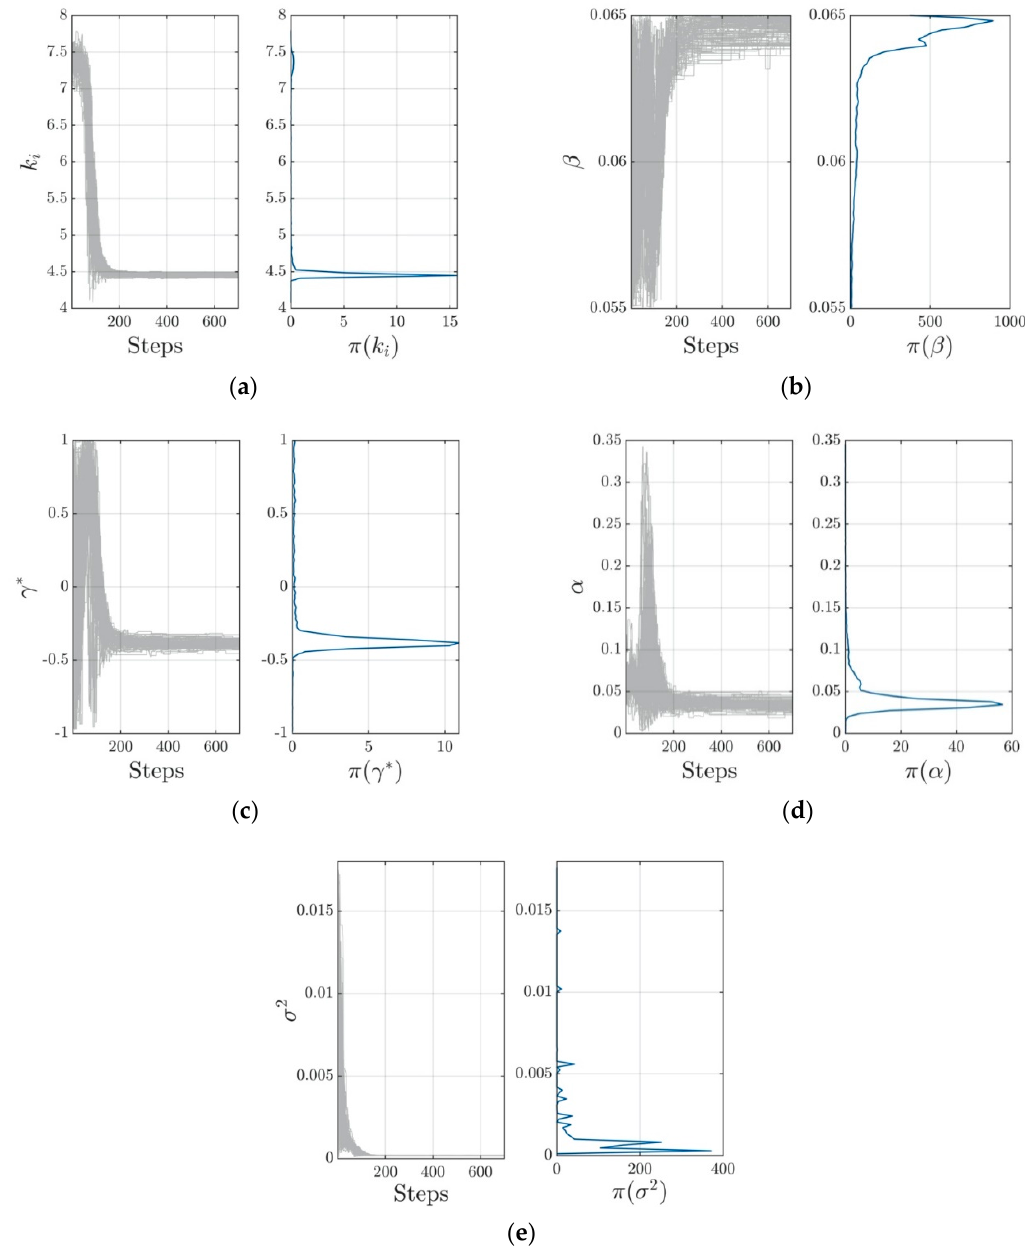
Figure 5. Trace plots of the Markov Chains and corresponding kernel density estimation (KDE) for each BWBN model parameter [6]: ( a ) k i ; ( b ) β ; ( c ) γ ∗ ; ( d ) α ; ( e ) σ 2 Table 3. Marginal posterior distribution of the BWBN benchmark model parameters.